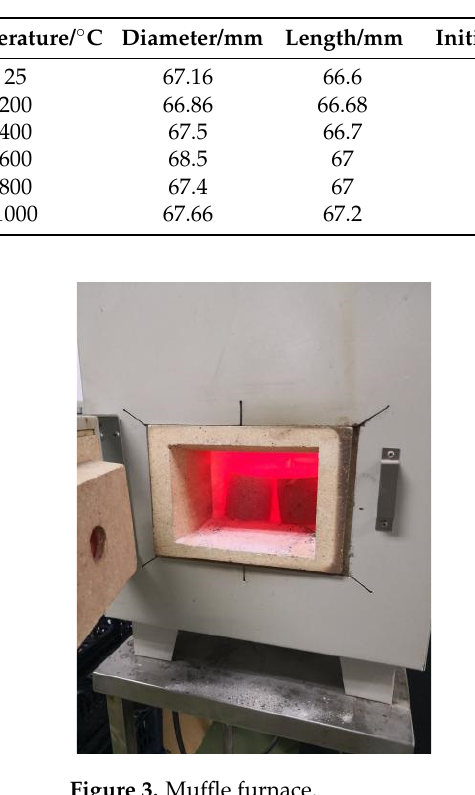
Table 1. Parameters of specimens.